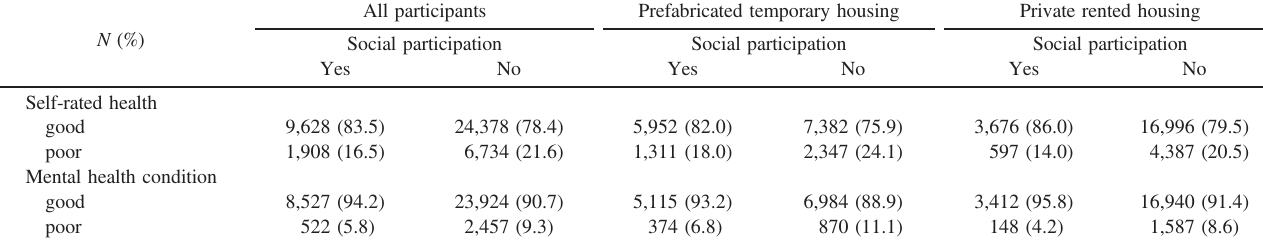
Table 2. Health conditions of participants with / without social participation a